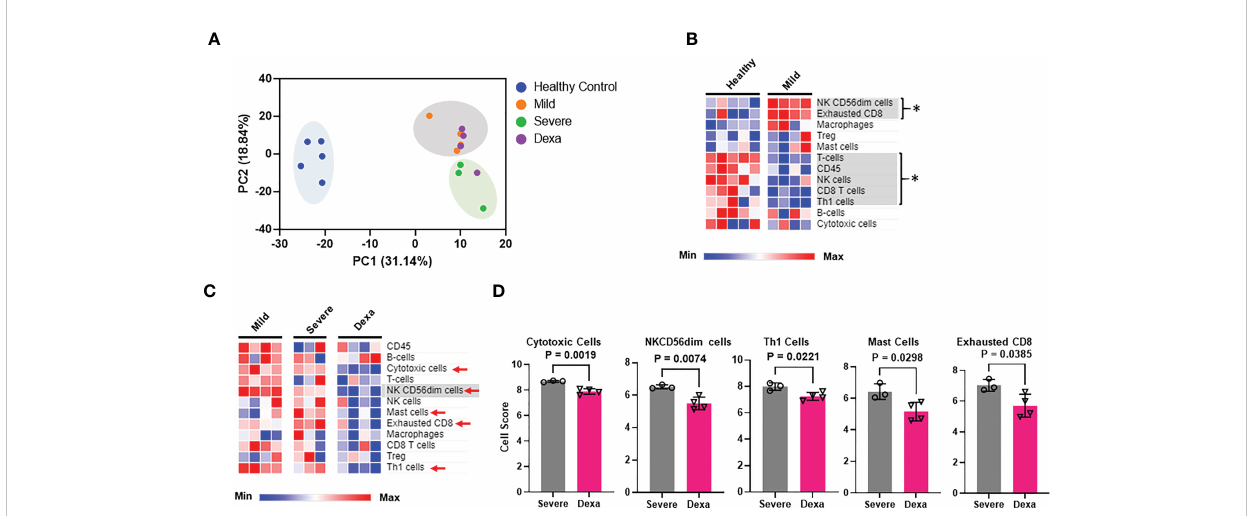
FIGURE 1 Immune cell pro fi ling of PBMCs from healthy controls, mild and severe COVID-19 patients and severe COVID-19 patients treated with dexamethasone. (A) Principal components analysis (PCA) of NanoString transcriptomic data. (B) Heatmap depicting immune cell abundance